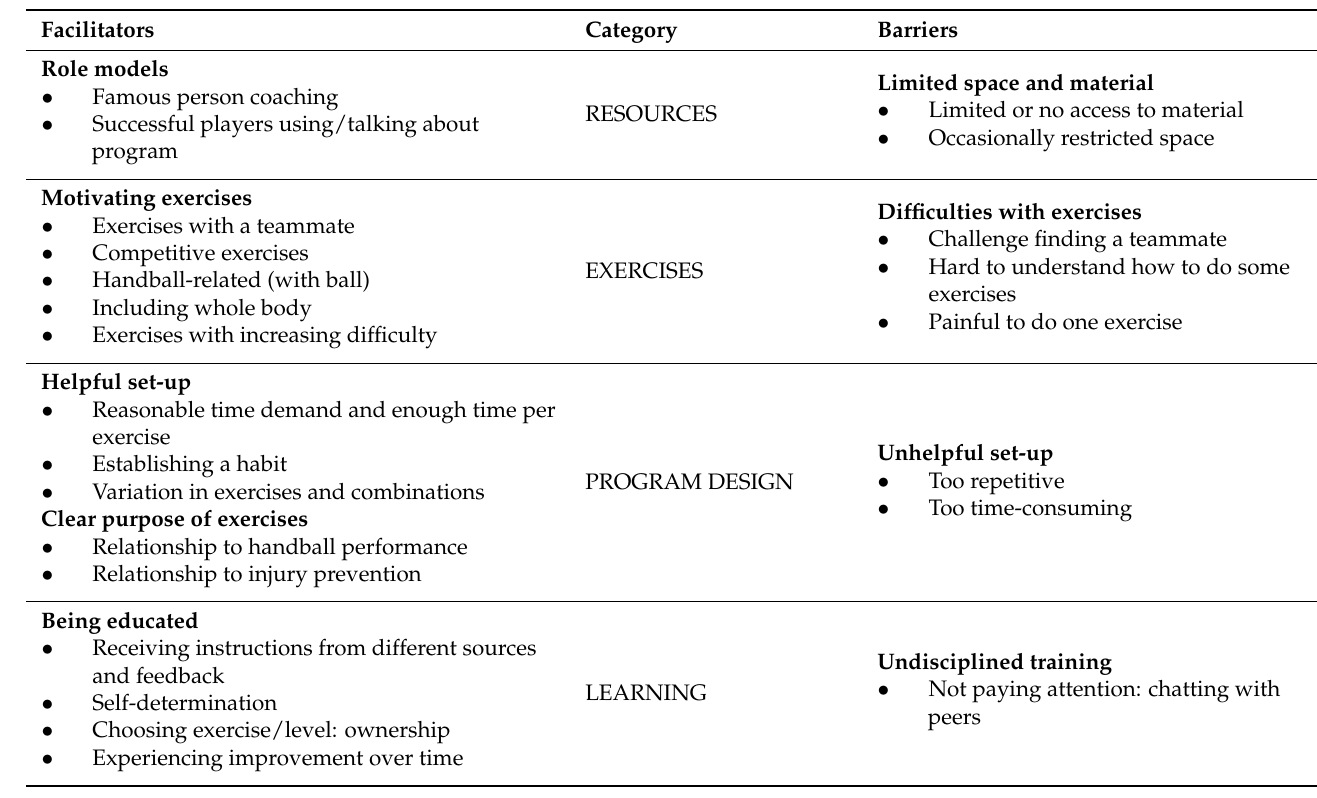
Table 2. Overarching categories and end-users’ evaluation of facilitators and barriers for injury prevention